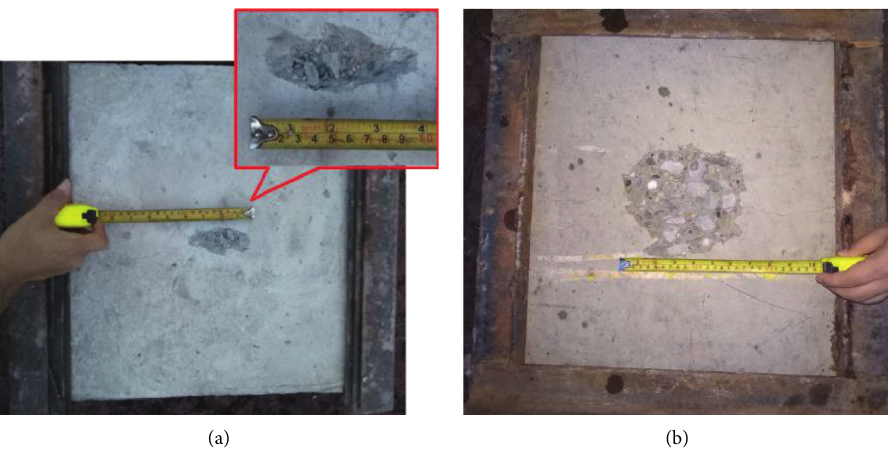
Figure 13: Test results of the cylindrical explosive. (a) Upper surface. (b) Bottom surface.